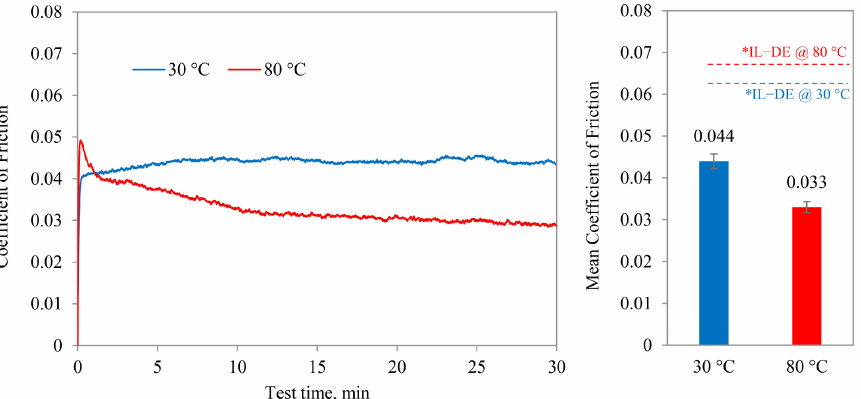
Figure 8. Variations of the coefficient of friction and its mean value observed during the PIL tribo-test. * friction coefficient values observed in our previous study